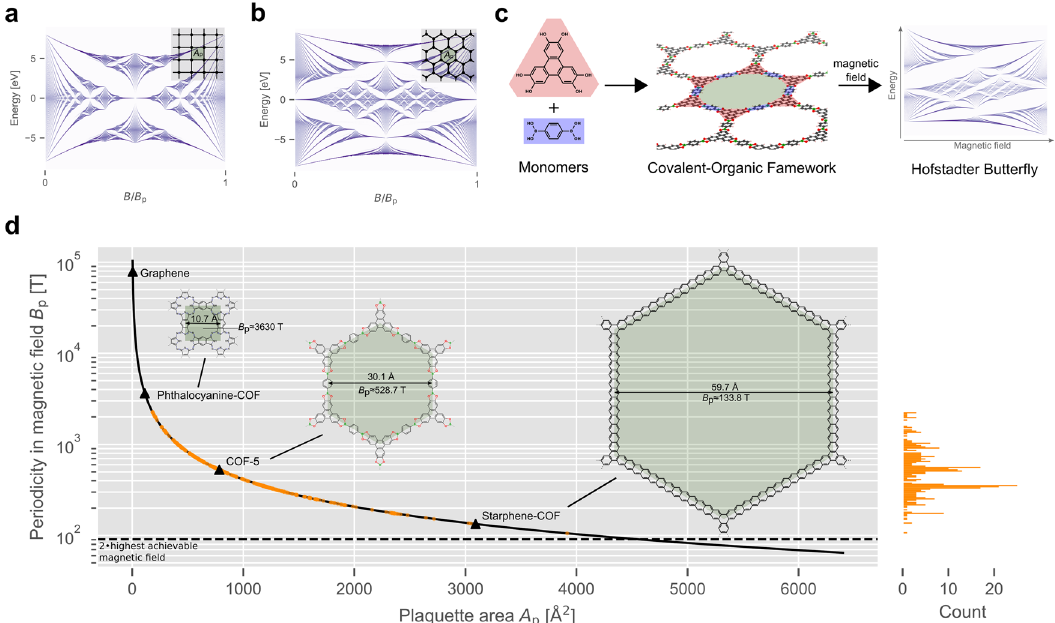
Fig. 1 From covalent organic frameworks to a measurable Hofstadter butter fl ies. a , b Application of a magnetic fi eld to a square (honeycomb) lattice with a plaquette area A p , marked as light green, leads to the fractal HB pattern with a period of B p . c From left to right: the lattice formation of COF-5 from its tritopic (red) and linear (blue) molecular building blocks. Applying a perpendicular magnetic fi eld to a COF leads to a HB resolved at small magnetic fi elds B p . d Relation between the magnetic fi eld to resolve a full HB B p and the area of a plaquette according to Eq. (1). The dashed black line indicates twice the highest continuous magnetic fi eld achievable to this date 44 . The orange points represent experimentally known COFs with square, tetragonal and honeycomb lattices collected from the CURATED-COFs database (for details on the curation, see Supplementary Note 1) 57 . The black triangles indicate graphene and the three COFs investigated in this study whose structures are